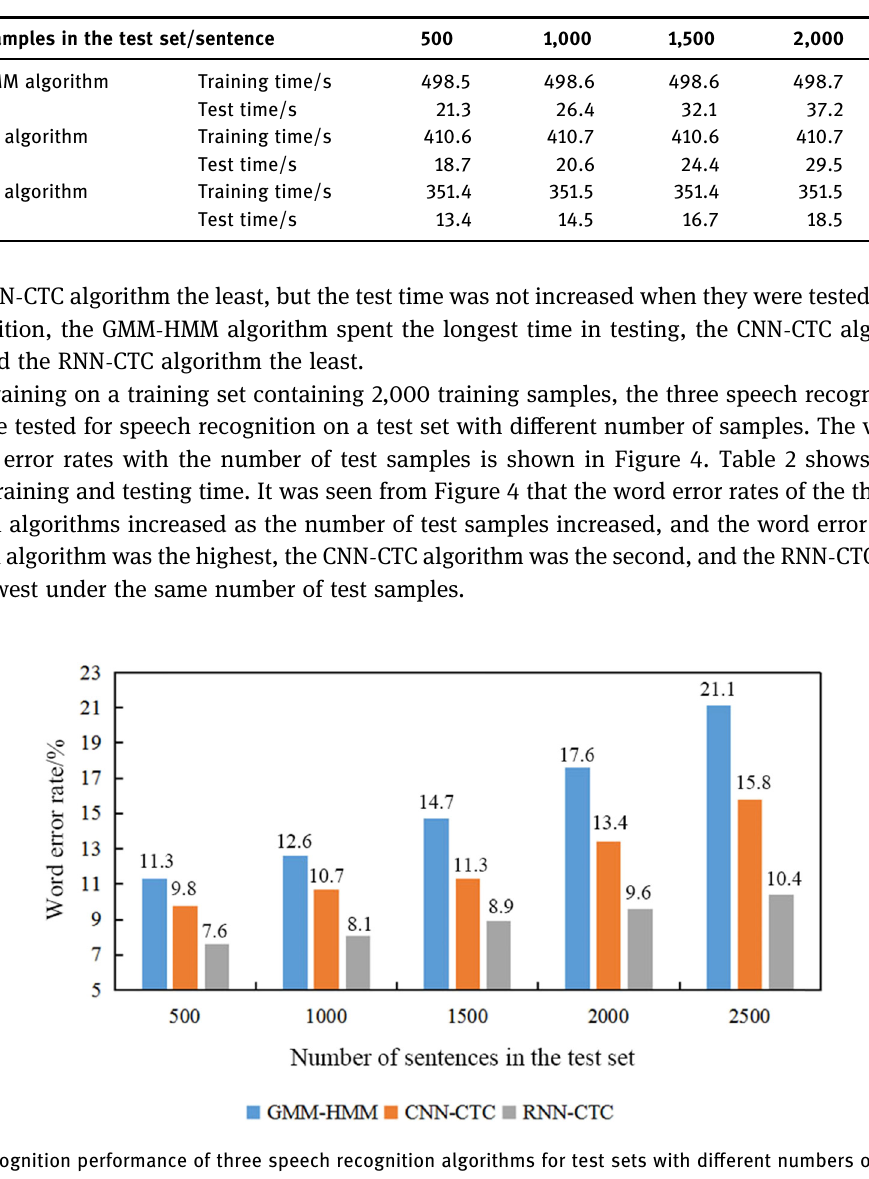
Figure 4: Recognition performance of three speech recognition algorithms for test sets with di ff erent numbers of